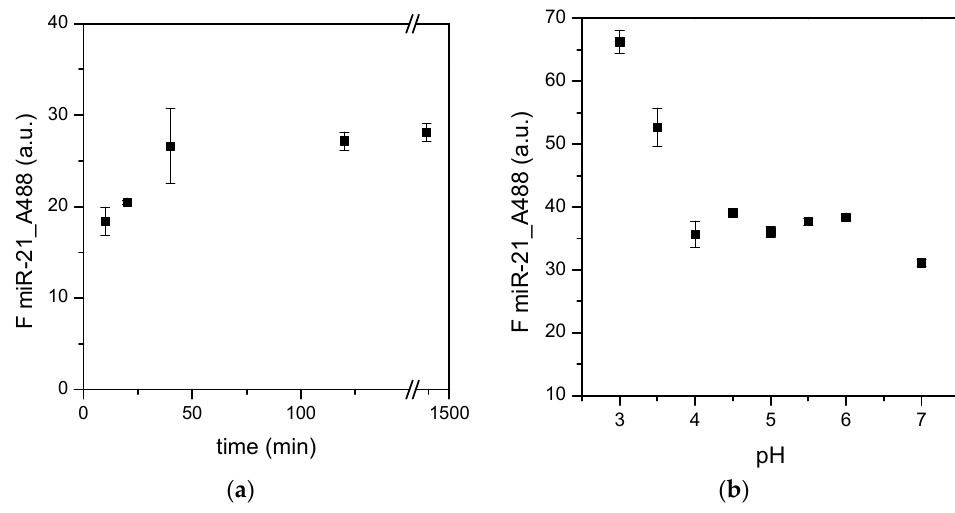
Figure 7. Adsorption at different incubation times of synthetic miR-21 conjugated with the fluorescent dye Alexa488 ( a ) and incubation at different pH levels ( b ). The same amounts of miR-21 were incubated (10 ng). Data are means of at least three surfaces. Standard errors are reported ( n ≥ 3).